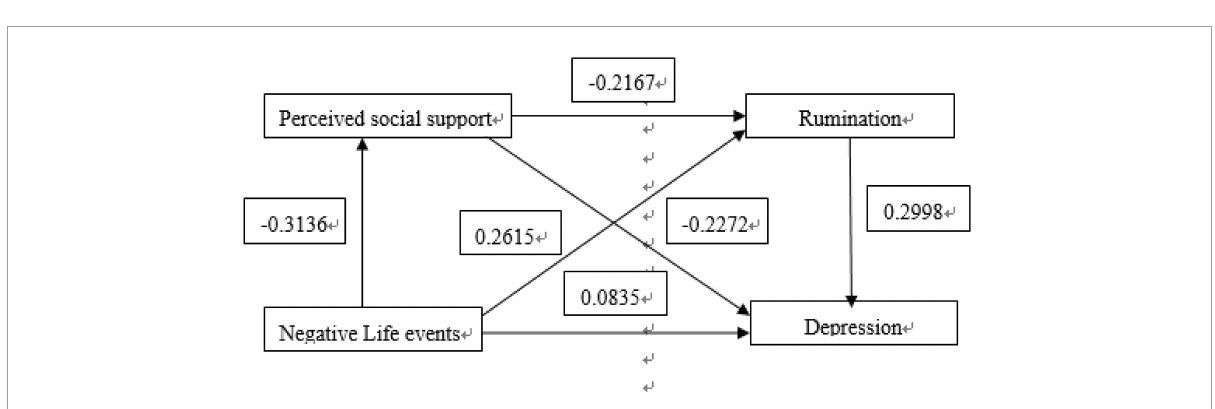
FIGURE2 Perceiving social support and ruminating influences in the chain-mediated model of the relationship between negative life events and